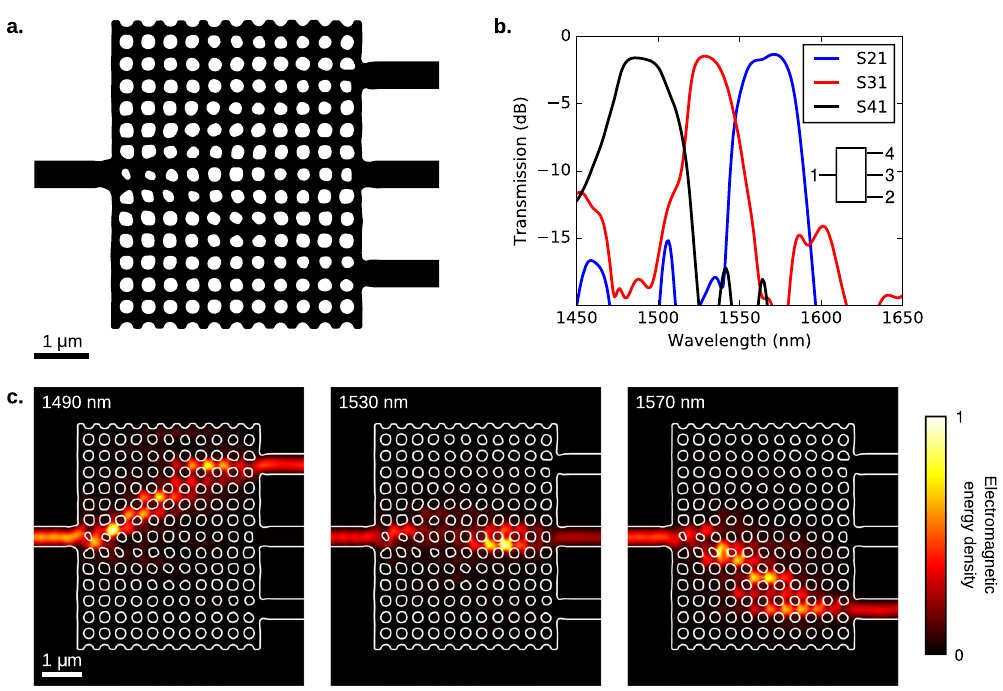
Figure 3. A compact 3-channel wavelength demultiplexer with a 40 nm channel spacing. The input and output waveguides are all 500 nm wide. Here, we present ( a ) the final design, ( b ) simulated S-parameters, and ( c ) the electromagnetic energy density at the three operating